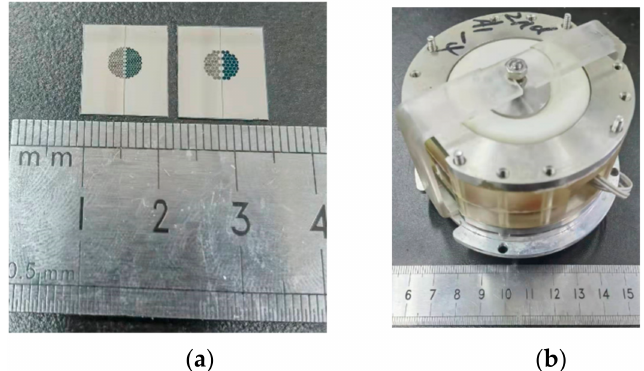
Figure 5. Prototyping images of the fabricated integrative structure of four centrosymmetric micro electrodes ( a ) which was assembled to form an electrochemical seismic micro sensor ( b